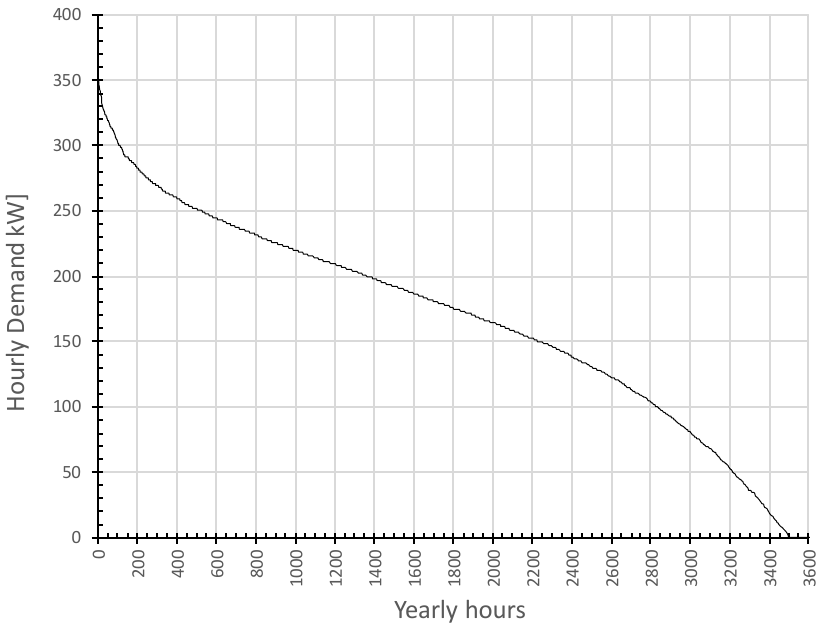
Figure 2. Annual cumulative heating demand profile for a set of block dwellings in Madrid built between 1981 to 2007 with 6000 m 2 of total heated surface.